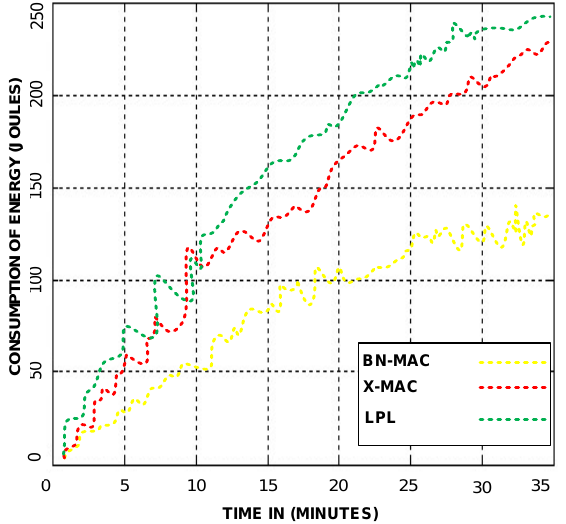
Figure 7. Energy consumption for BN-MAC and low-duty-cycle MAC protocols.